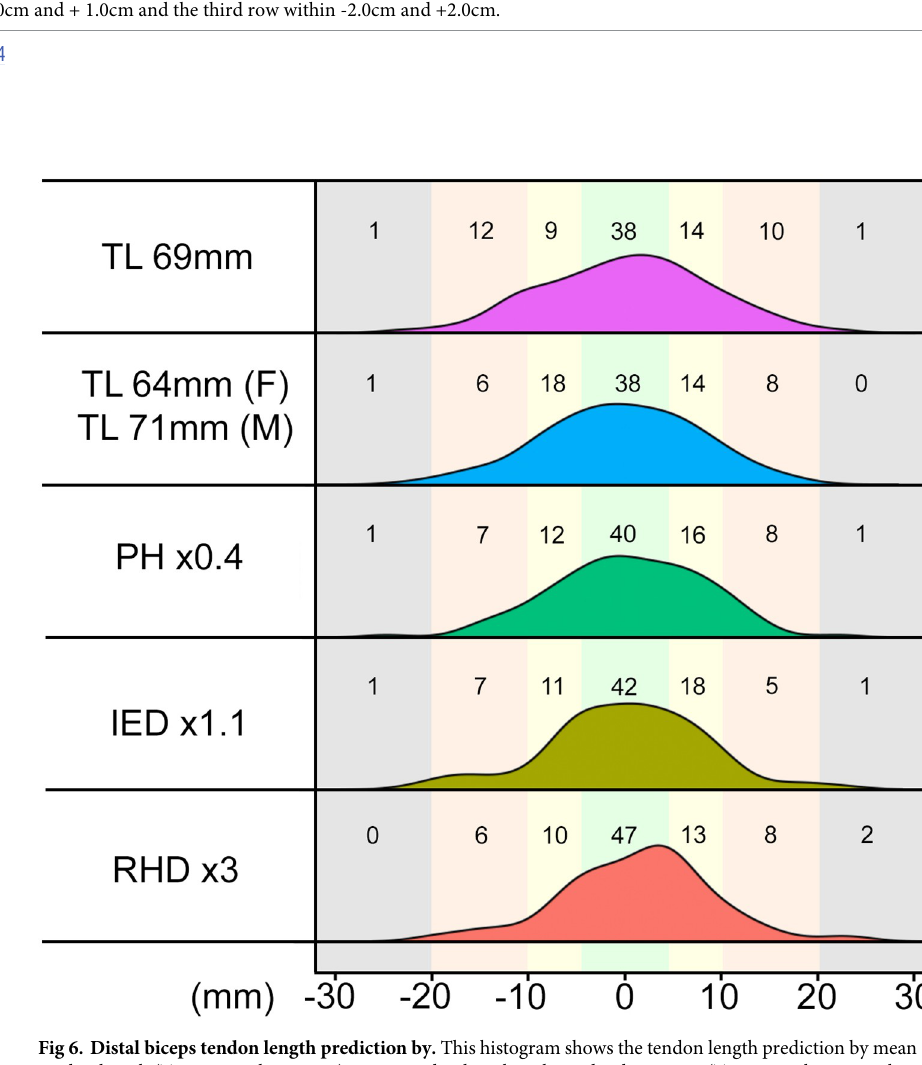
Table 4. Distal biceps tendon length prediction by. % � +/-0.5cm % � +/-1.0cm % � +/-2.0cm Mean tendon length (TL) 69mm 38 (= 45%) 61 (= 72%) 83 (= 98%) Mean tendon length (TL) 64mm (F) / 71mm (M) 38 (= 45%) 70 (= 82%) 84 (= 99%) Patient’s height (PH) (cm) x0.4 40 (= 47%) 68 (= 80%) 83 (= 98%) Inter-epicondylar distance (IED) x1.1 42 (= 49%) 71 (= 84%) 83 (= 98%) Radial head diameter (RHD) x3.0 47 (= 55%) 70 (= 82%) 82 (= 96%) The anatomical length of the distal biceps tendon was predicted by mean tendon length (TL), TL with gender distinction, patient’s heigth (PH), inter-epicondylar distance (IED) and radial head diameter (RHD). The first row shows the number and percentage of tendons which could be predicted within -0.5mm and +0.5mm of the original length. The second row within -1.0cm and + 1.0cm and the third row within -2.0cm and +2.0cm.